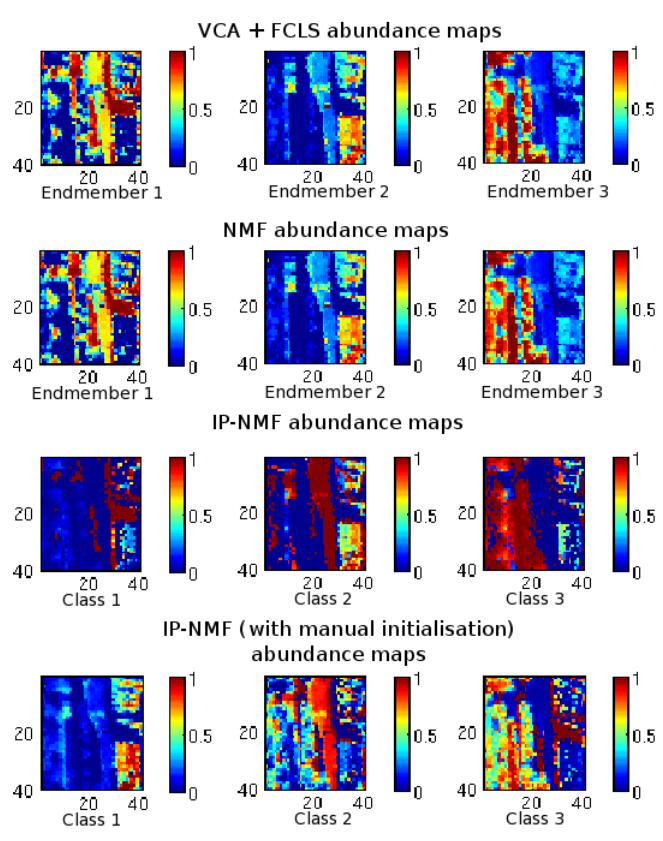
Figure 12. Abundance maps obtained for M = 3 with four methods: VCA + FCLS (1st line), standard NMF (2nd line), IP-NMF initialised with VCA (3rd line) and IP-NMF initialised with manually selected spectra (4th line).